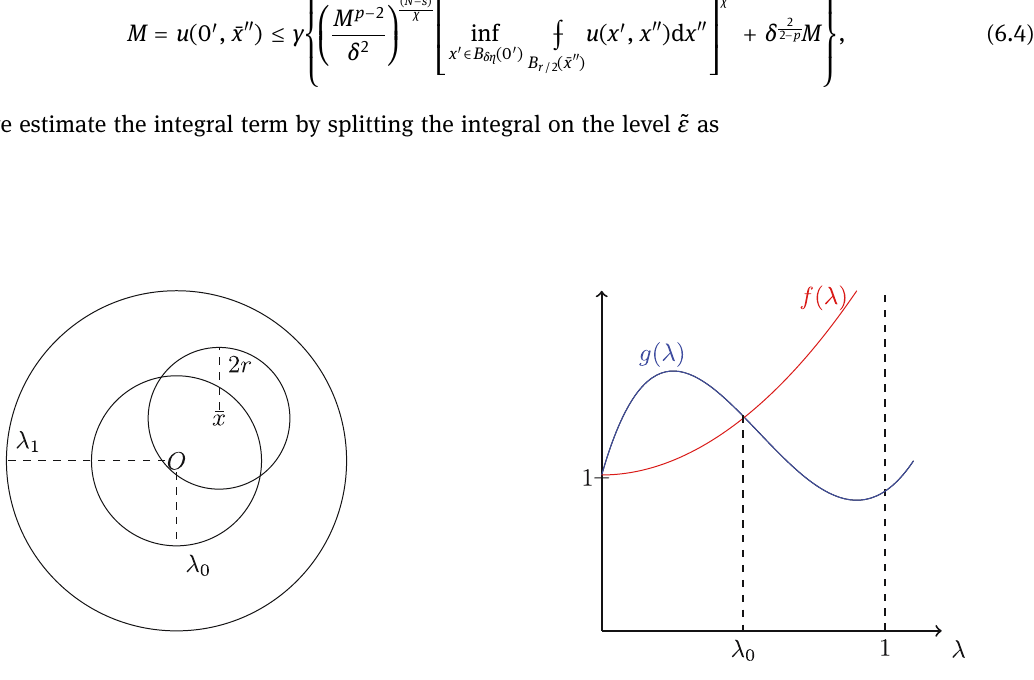
Figure 1: ( Left ) The geometric construction of ( ) B x ¯ r 2 , with = ρ 1 and = u 1 0 . ( Right ) The idea of de fi nition of λ 0 through equation ( 6.1 ) . Function f ( in red ) represents the member on the right - hand side of equation ( 6.1 ) while function g ( in blue ) represents the left - hand side